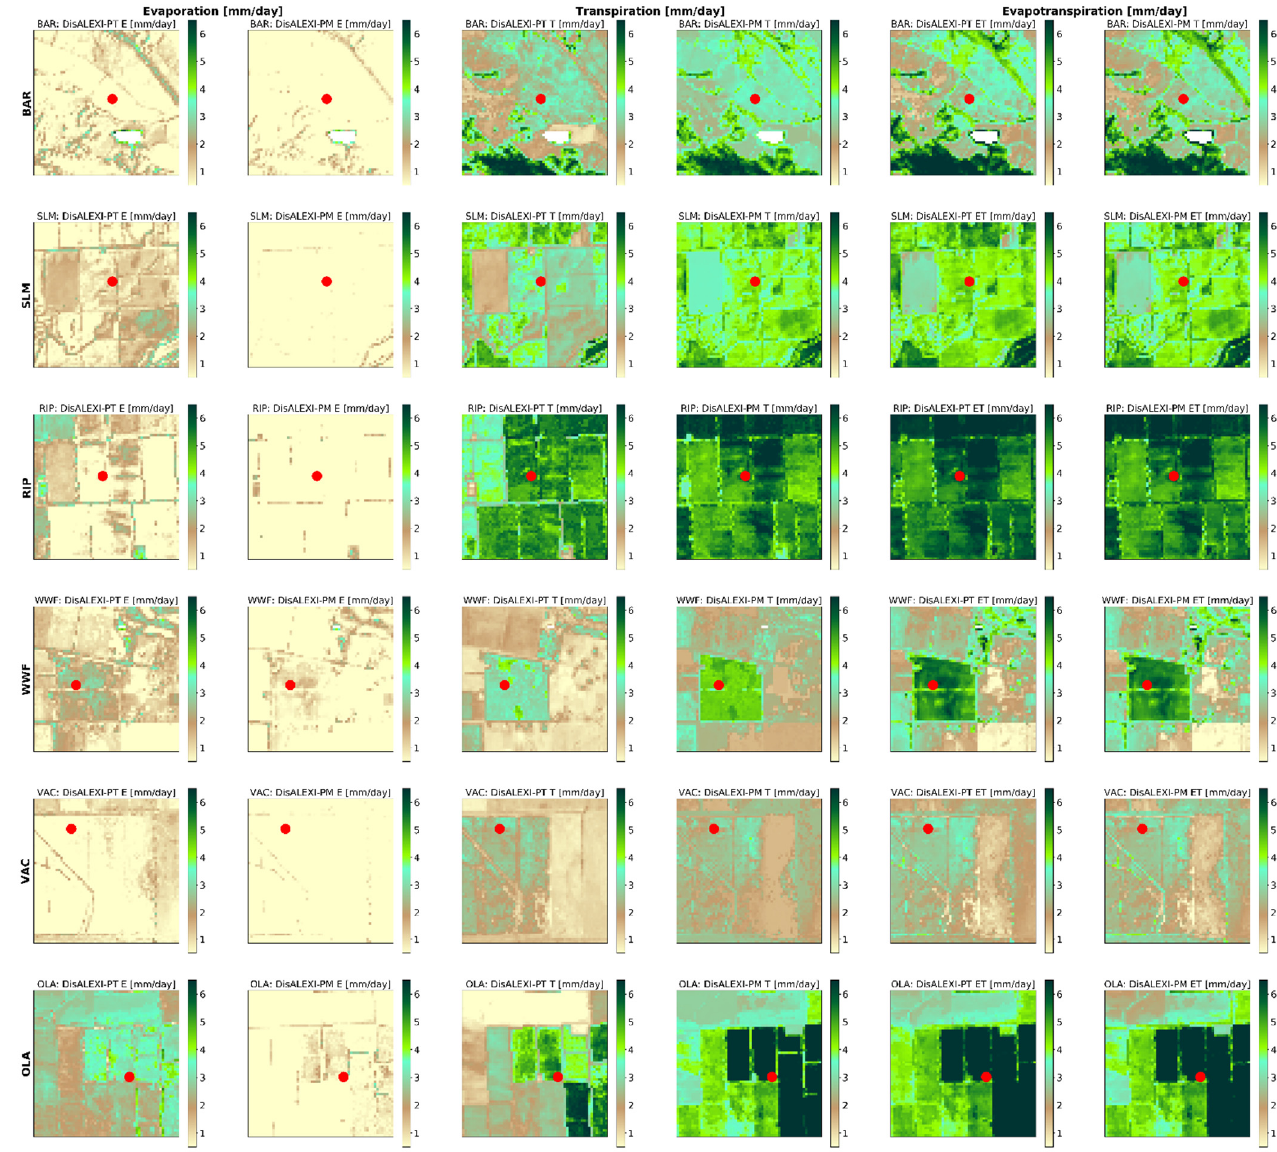
Figure 10. Spatial maps of daily E (left two columns), daily T (middle two columns), and daily ET ( right two columns ) in mm day − 1 for DisALEXI-PT and DisALEXI-PM (next to one another) for all sites on Landsat-8 overpass dates in June 2021 (specific dates listed in text). The red dot indicates flux tower location.